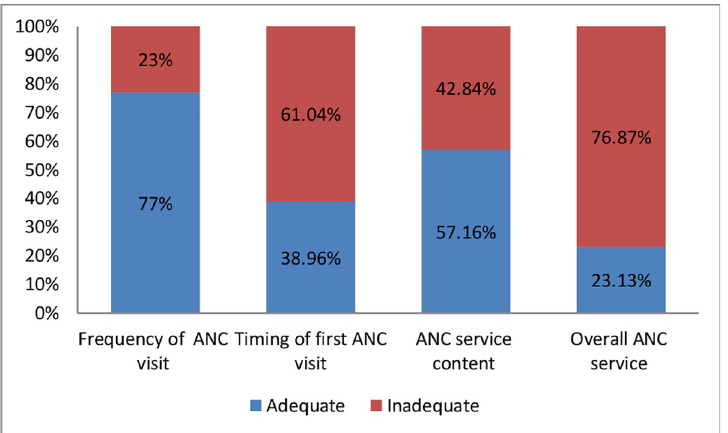
Fig 1. Distribution of respondents according to antenatal utilization attributes among mothers in Southern Ethiopia, 2019.